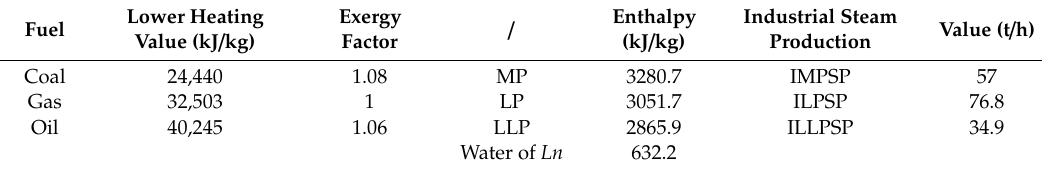
Table 6. Parameters of the resource.